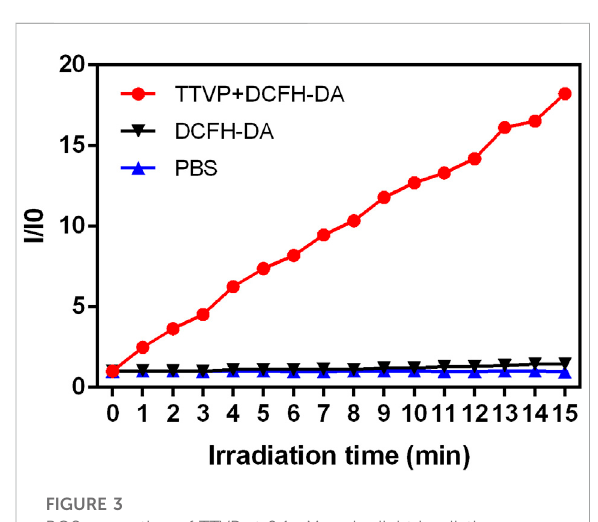
FIGURE 3 ROS generation of TTVP at 0.1 μ M under light irradiation (20 mW/cm 2 ) for 15